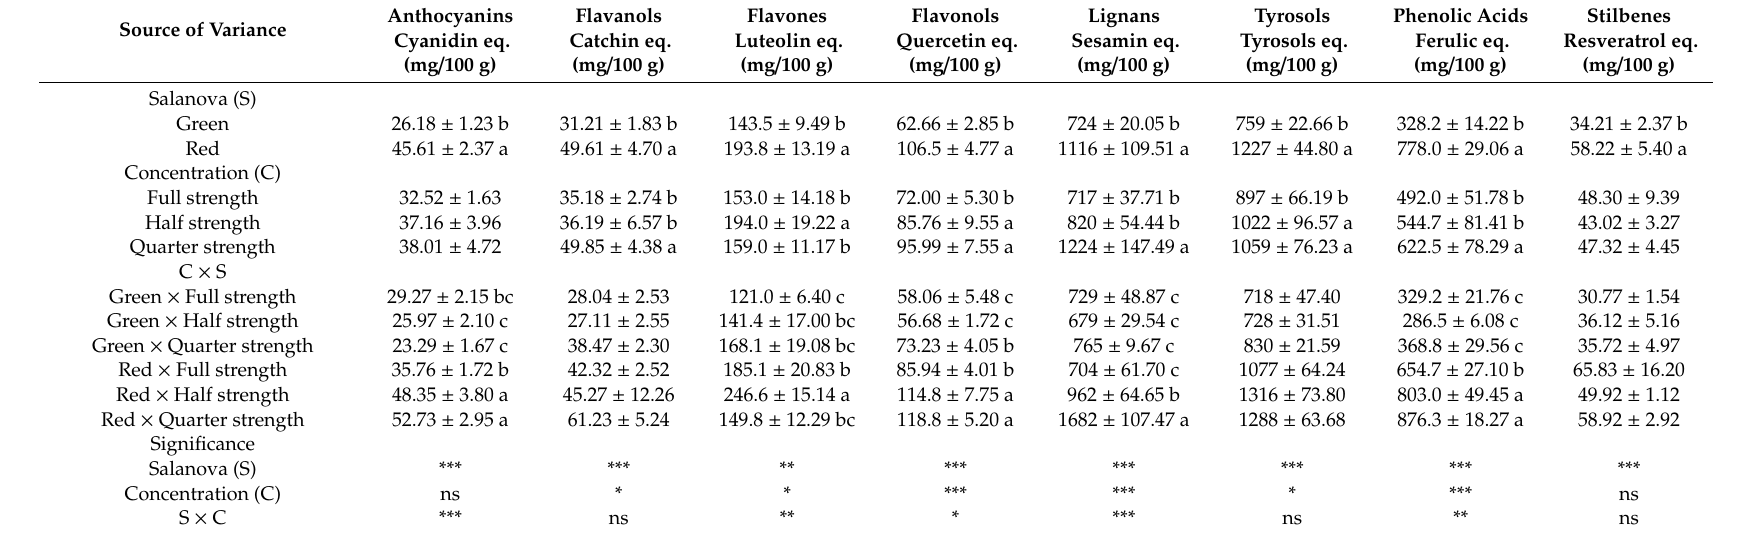
Table 1. Semi-quantitative profile of phenolic compounds in green and red Salanova lettuce (S) in nutrient solutions with di ff erent macrocations concentration (C). Results are cumulative untargeted-metabolomics profiling data per each phenolic